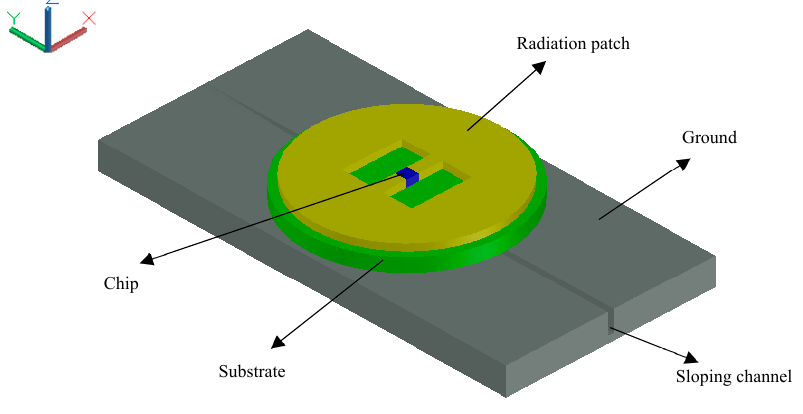
Figure 3. Displacement sensor.